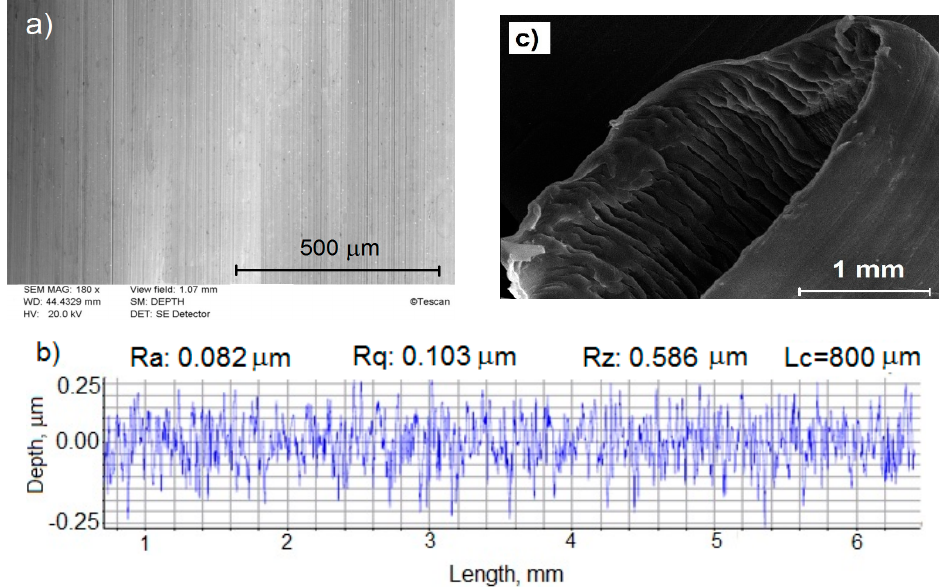
Figure 24. Scanning electron microscopy of the results: ( a ) finished UHMWPE surface - free of burrs,